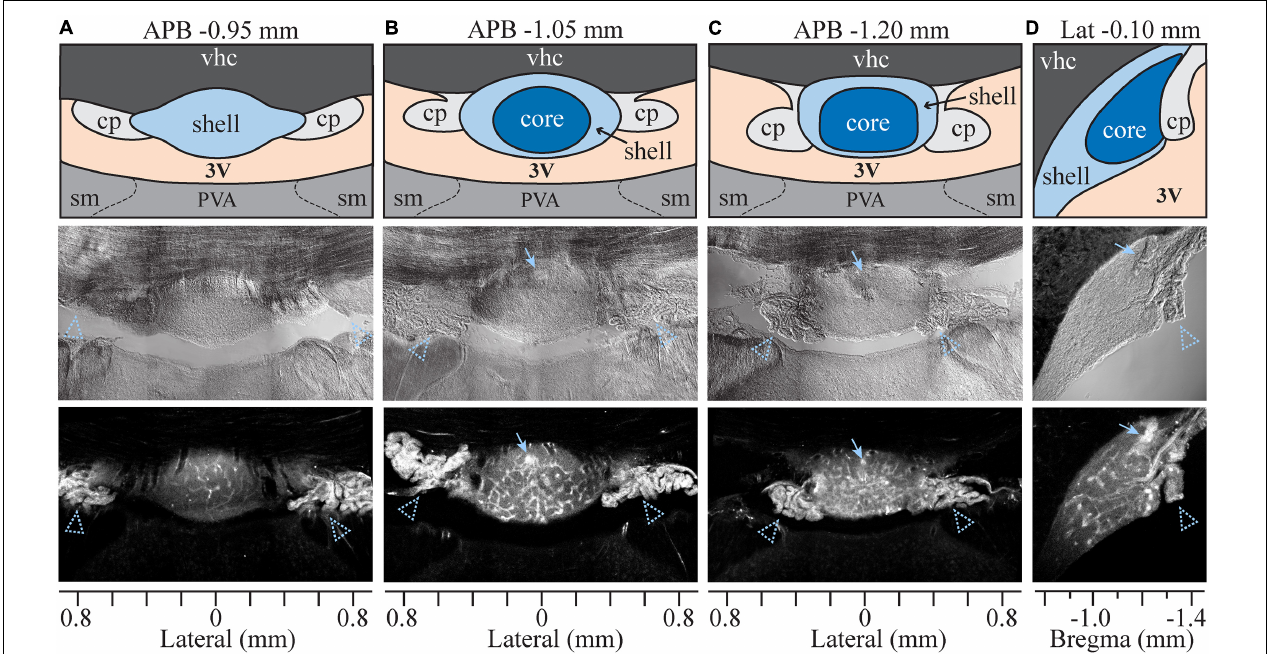
FIGURE 1 | Evans Blue analysis in sagittal and coronal planes. Four sets of column panels show the organization of the SFO and surrounding anatomical structures in coronal plane through the rostral (A) , medial (B) and caudal (C) SFO, and in mid-sagittal plane (D) . Anterior-posterior bregma (APB) and lateral coordinates (for the sagittal plane) are indicated above each column. Axes at the bottom of each column show lateral (A–C) or bregma (D) coordinates in millimeters. Middle and bottom rows show brightfield and Evan Blue (EB) fluorescence respectively, and the top row displays schematic diagrams depicting the SFO and surrounding anatomical structures corresponding to micrographs below. Blue arrows indicate subfornical artery and arrowheads choroid plexus. 3V, third ventricle; vhc, Ventral hippocampal commissure; cp, choroid plexus; PVA, anterior nucleus of paraventricular thalamus; sm, stria